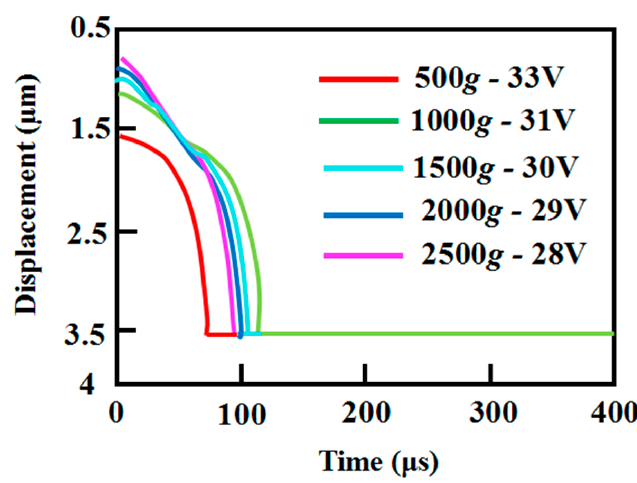
Figure 7. Electromechanical coupling of inertial switch.